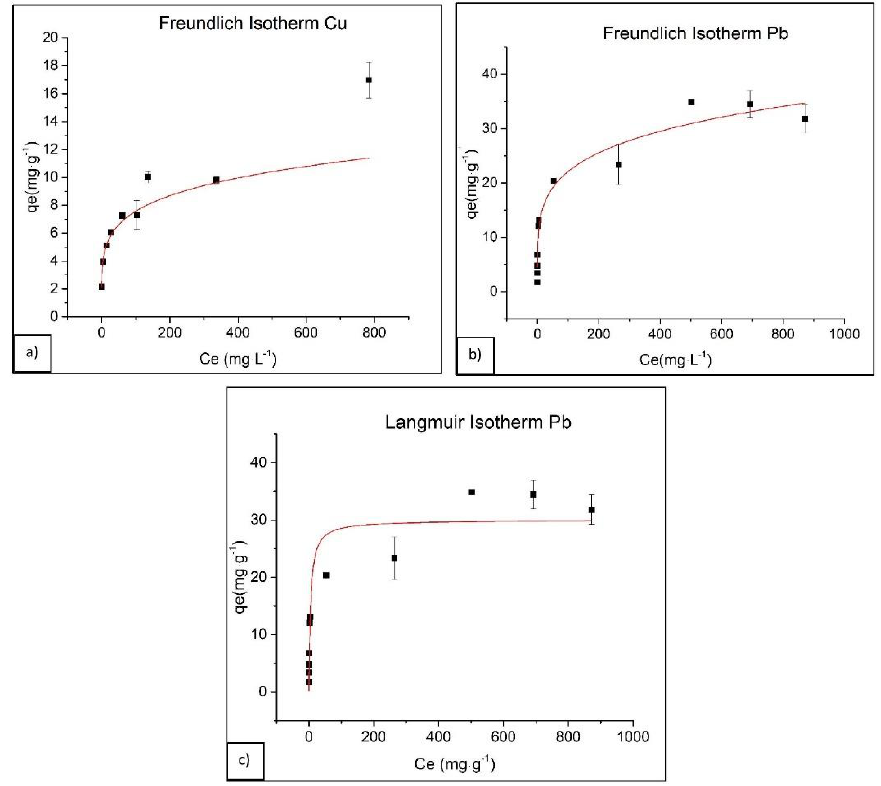
Figure 5. Freundlich and Langmuir Isotherm curves for ( a , b ) Cu and ( c ) Pb.